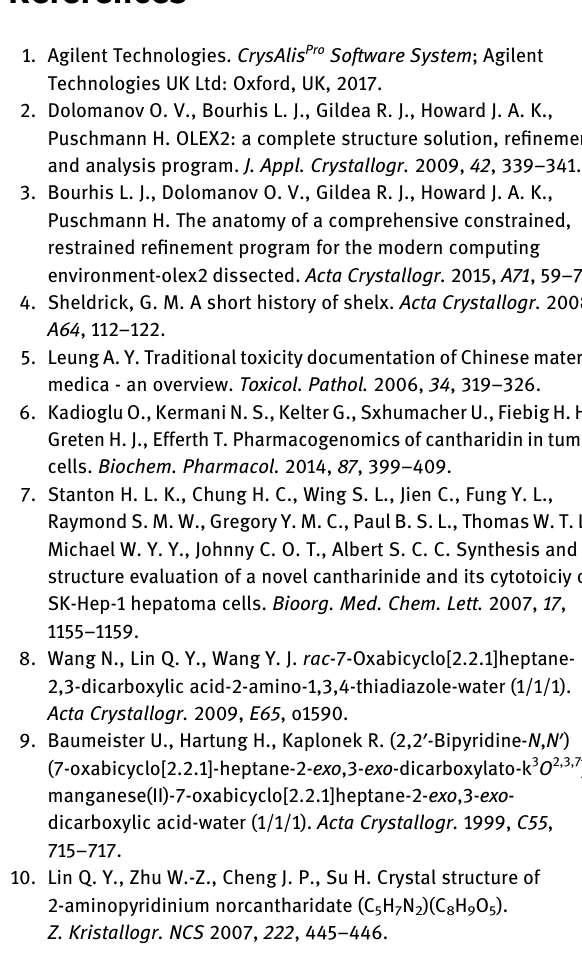
tetrahydrofuran rings having the cis-arrangement at the ring junctions, giving a V-shaped molecule. From the X-ray studies it was deduced that intermolecular hydrogen